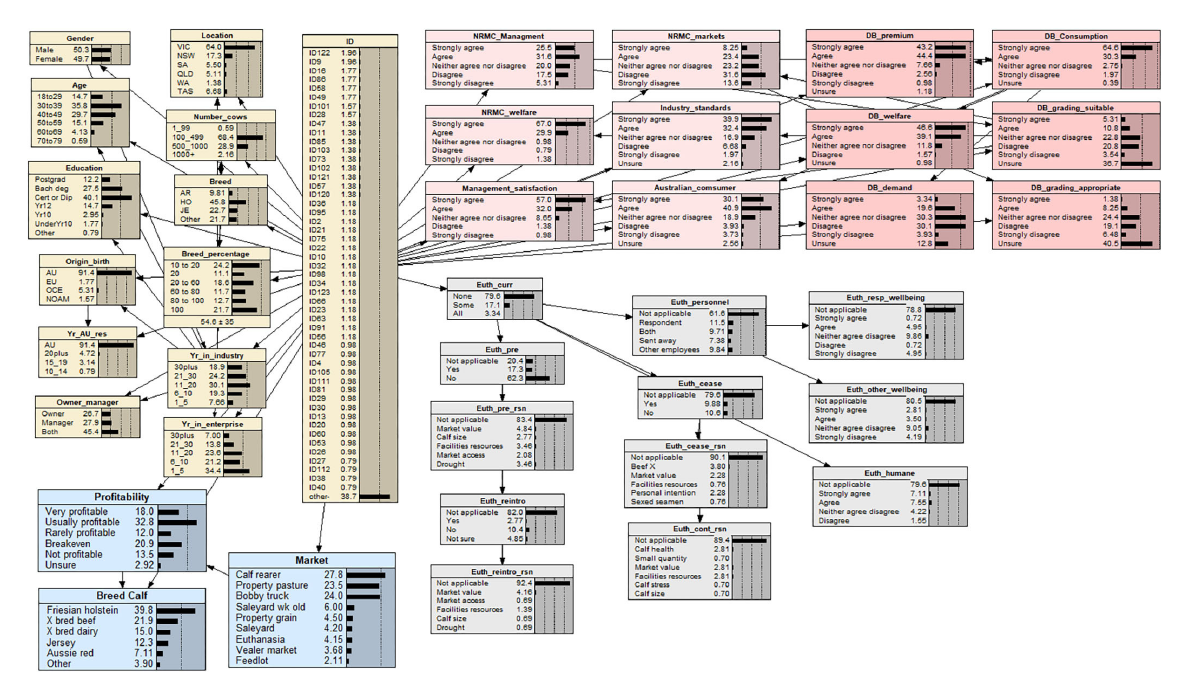
FIGURE2 A Bayesian network (BN) model of the dependency relationships between practice and attitude variables of Australian dairy producers (127 participants) regarding non-replacement male calves. Each variable in the BN model is represented by a node. The link between two nodes represents the dependency relationship between two variables. The middle column of each node is a percentage totaling to 100%, which represents the analysis outcomes of each level within a node. The last column is a graphical representation of the percentage values for each level shown as distribution bars. The dotted lines are markers that are equally spaced to aid in visualizing the comparative heights of the distribution bars. Descriptions of each variable and their levels are presented in Supplementary Table 1.